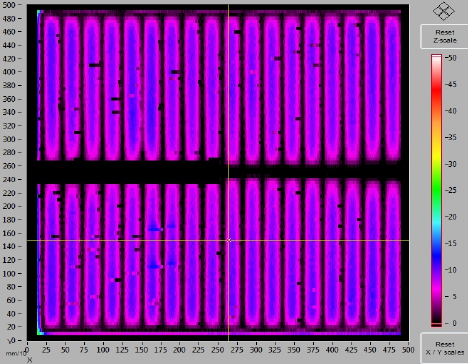
Figure 5. An example of the graphical distribution of the resistance of a photovoltaic cell with front metallisation fired in an infrared IR furnace at a temperature of 940 °C (original 2D printout from the Corescan device software)